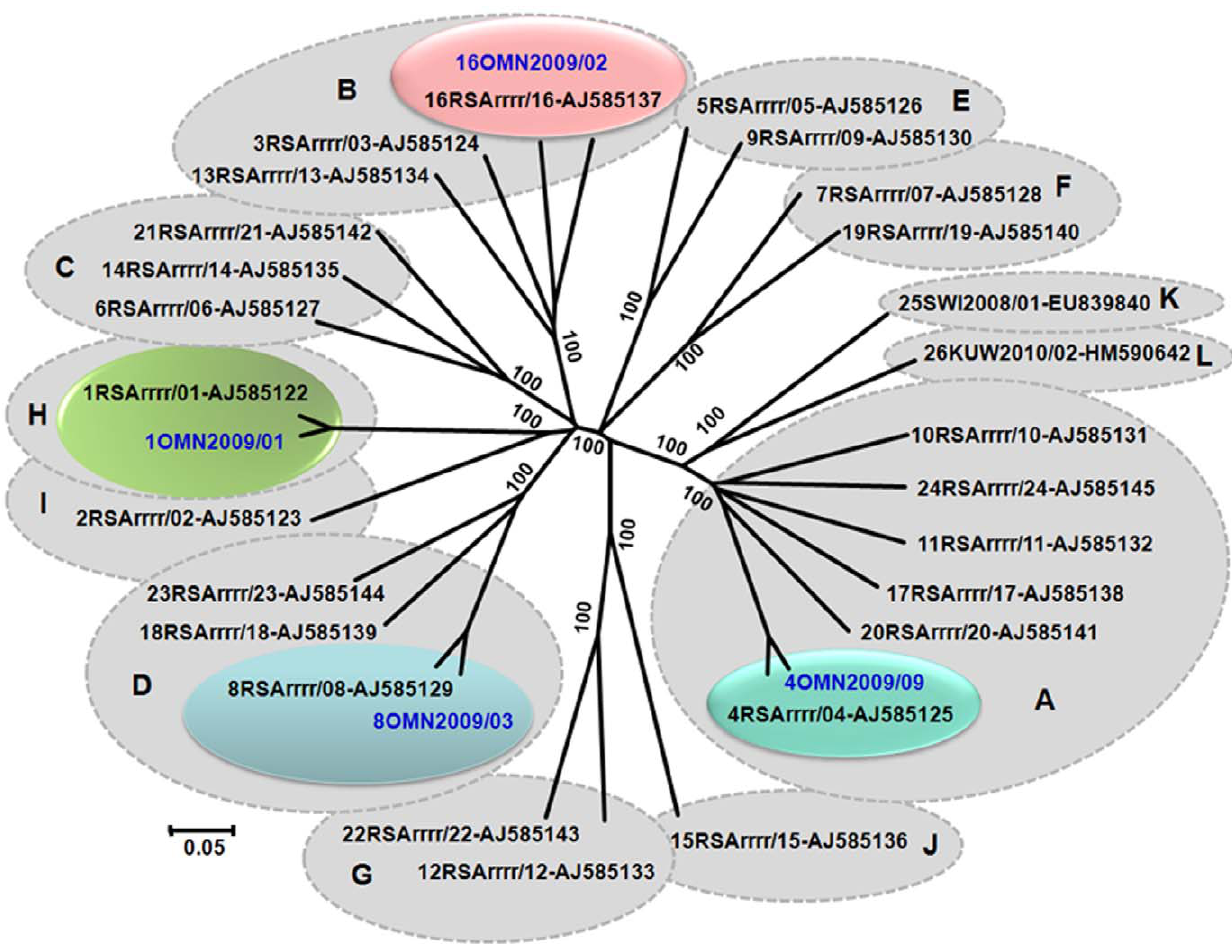
Figure 2. Neighbour-joining tree, showing relationships in Seg-2 between reference and field strains of BTV-1w, 4w, 8w and 16w from Oman. The tree was constructed using distance matrices, generated using the p-distance determination algorithm in MEGA5 (500 bootstrap replicates) [48]. BTV split into 26 distinct groups based on Seg-2 sequences, reflecting serological relationships between virus strains [18]. Reference strains of BTV are shown in black and field isolates from Oman are shown in blue font. Isolate designations: IAH ‘dsRNA virus reference collection number’ composed of country code, year, and the number of the isolate in that year from that country [66]. Full length Seg-2 sequences of BTV-1/ OMN2009/01, BTV-4/OMN2009/09, BTV-8/OMN2009/03 and 16/OMN2009/02 showed 95%, 94%, 93% and 73.6% nucleotide (nt) identity to the reference strains of respective serotype, confirming their types and topotypic groups.Scale represents number of substitutions per site. Values at major branching points represent NJ bootstraps.